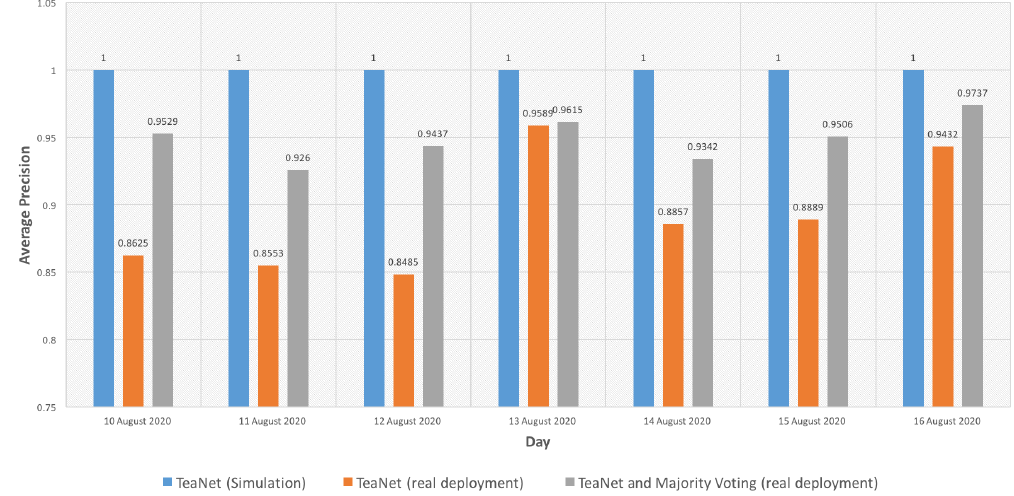
Figure 9. Average precision of the TeaNet system in monitoring optimum tea fermentation.